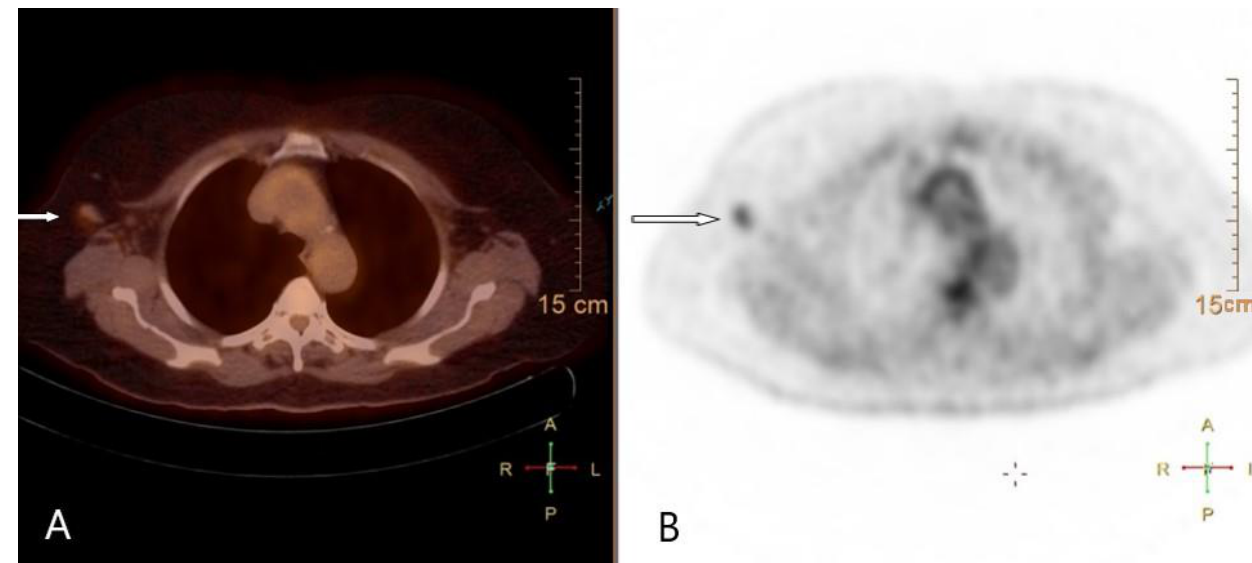
Figure 1. FDG PET/CT ( A ) and FDG PET ( B ) images shows FDG uptake (arrows) in a right axillary lymph node with a maximum standardized uptake value of 2.0.